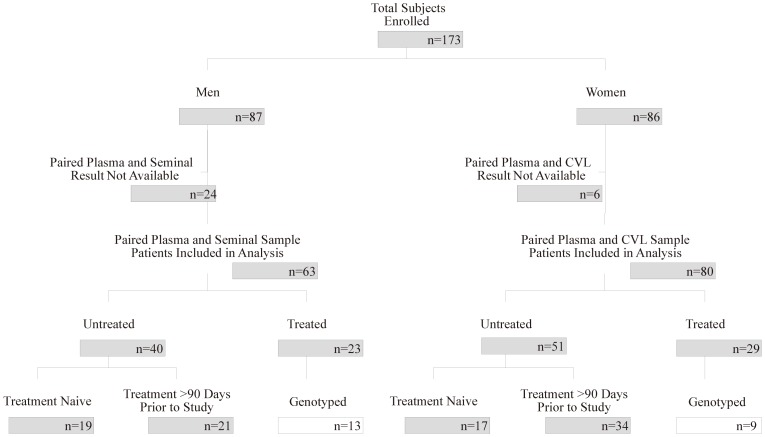
Flowchart of Enrolled Subjects and Available Samples by Sex.White boxes represent the subset of subjects with genotypes available from both blood and genital secretions. The ‘untreated’ group refers to subjects who were either antiretroviral drug naïve or who had been off ART for ≥90 days.